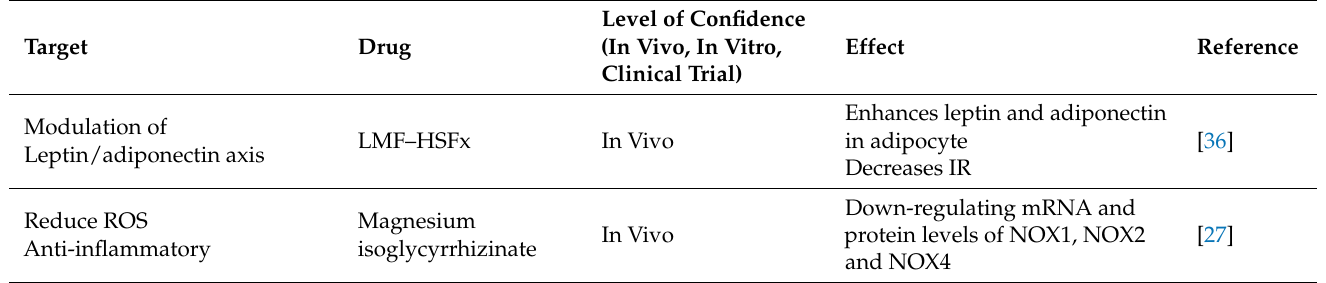
Table 1. Drugs that limit inflammation in NAFLD development and its more sever condition,